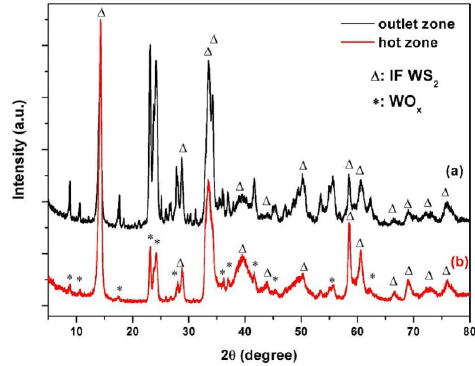
Figure 6. XRD patterns of samples collected from different areas ( a , outlet and b , hot zone) in experiment AHS1.